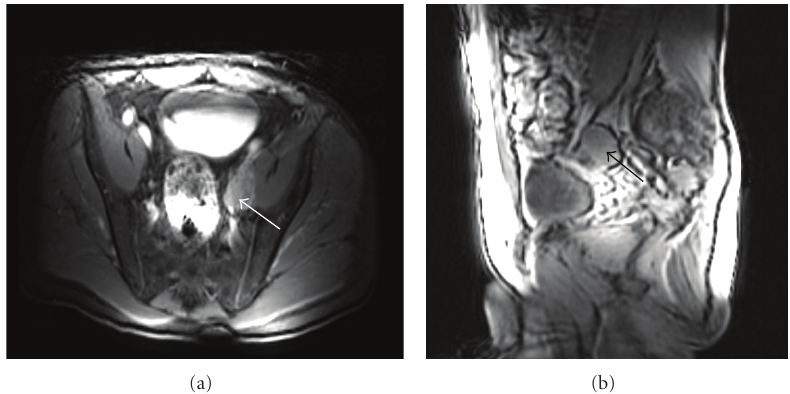
Figure 1: Axial and sagittal magnetic resonance images showing an enlarged left external iliac lymph node (white arrow axial, black arrow sagittal).